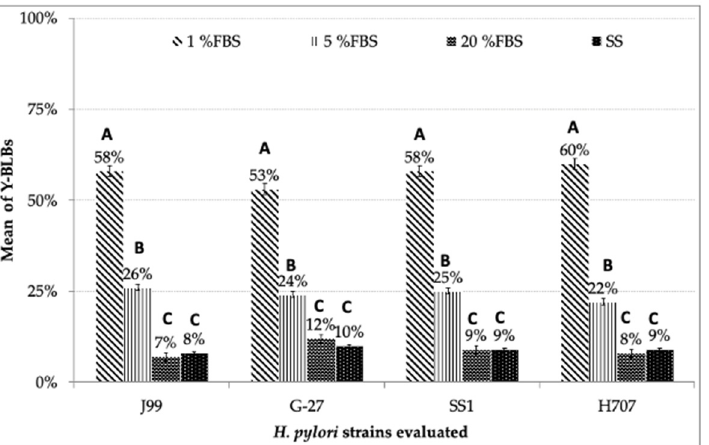
Figure 6. Mean percentage of Y-BLBs when H. pylori and Candida spp. were co-cultured in BB supplemented with 1%, 5% or 20% FBS concentrations or in SS. Mean percentages of Y-BLBs remained above 50% in the co-cultures supplemented with 1% FBS. No significant differences were observed between the percentages of Y-BLBs obtained in the co-cultures evaluating the same strains of H. pylori in the presence of different FBS concentrations. Different letters indicate significant differences ( p < 0.05).